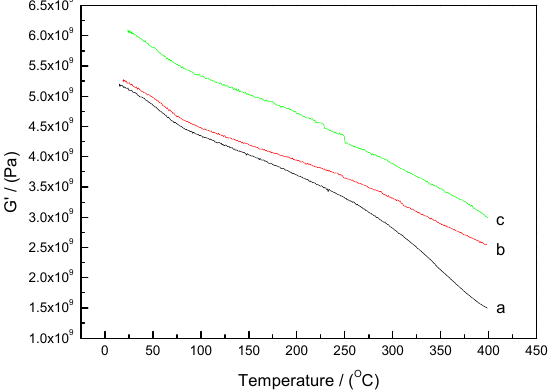
Figure 8. Dynamic storage modulus ( G ’) as a function of temperature for the neat polymer after a post-cure treatment at: (a) 350 °C for 4 h, (b) both 350 and 375 °C for 4 h, and (c) 350 °C for 8 h and 375 °C for 4 h.